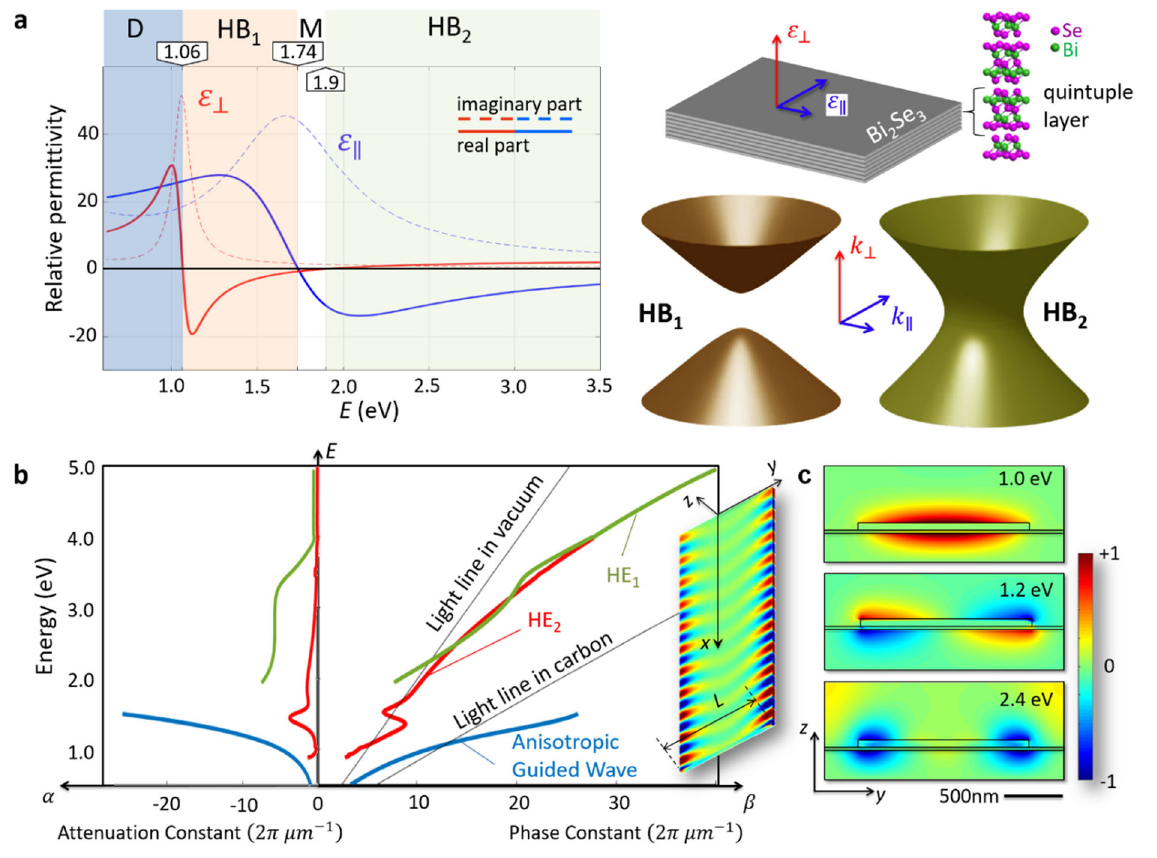
Fig. 2 Hyperbolic properties of Bi 2 Se 3 due to high spatial anisotropy. a Relative permittivity of bulk Bi 2 Se 3 , acquired by ellipsometry measurements. Anisotropic guided waves (D), hyperbolic type-1 (HB 1 ), and hyperbolic type-2 (HB 2 ) waves are supported at the energies highlighted by blue, orange, and green colors, respectively. In-plane and out-of-plane directions within the layered van der Waals crystal and isofrequency sheets related to hyperbolic type- 1 and type-2 behavior are shown in addition. b Dispersion diagram of the different optical modes, supported by a Bi 2 Se 3 nanoplatelet in the form of a channel waveguide (only lower order modes are shown; for a full diagram including experimental data see Supplementary Fig. 2). HE 1 and HE 2 indicate hybrid magnetic-like modes. The inset graphic shows the simulated spatial distribution of the z -component of the electric fi eld associated with the HE 1 mode, which propagates in the x -direction along an in fi nitely long waveguide. c The z -component of the electric fi eld at the cross-sections associated with the anisotropic guided wave, hyperbolic type-1 HE 2, and hyperbolic type-2 HE 1 channel modes, are shown at the depicted energies from top to bottom,